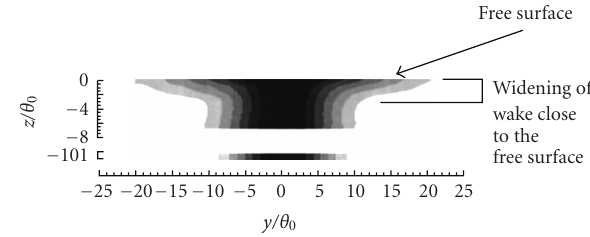
Figure 2: Widening of the wake close to the free-surface (Adopted from Logory et al., [41]). The contour color represents mean velocity; white to dark shade represents higher to lower range of streamwise velocity. θ 0 ( = 3.1mm) is the half-momentum thickness of the wake (Reproduced with the permission of American Institute of Physics).